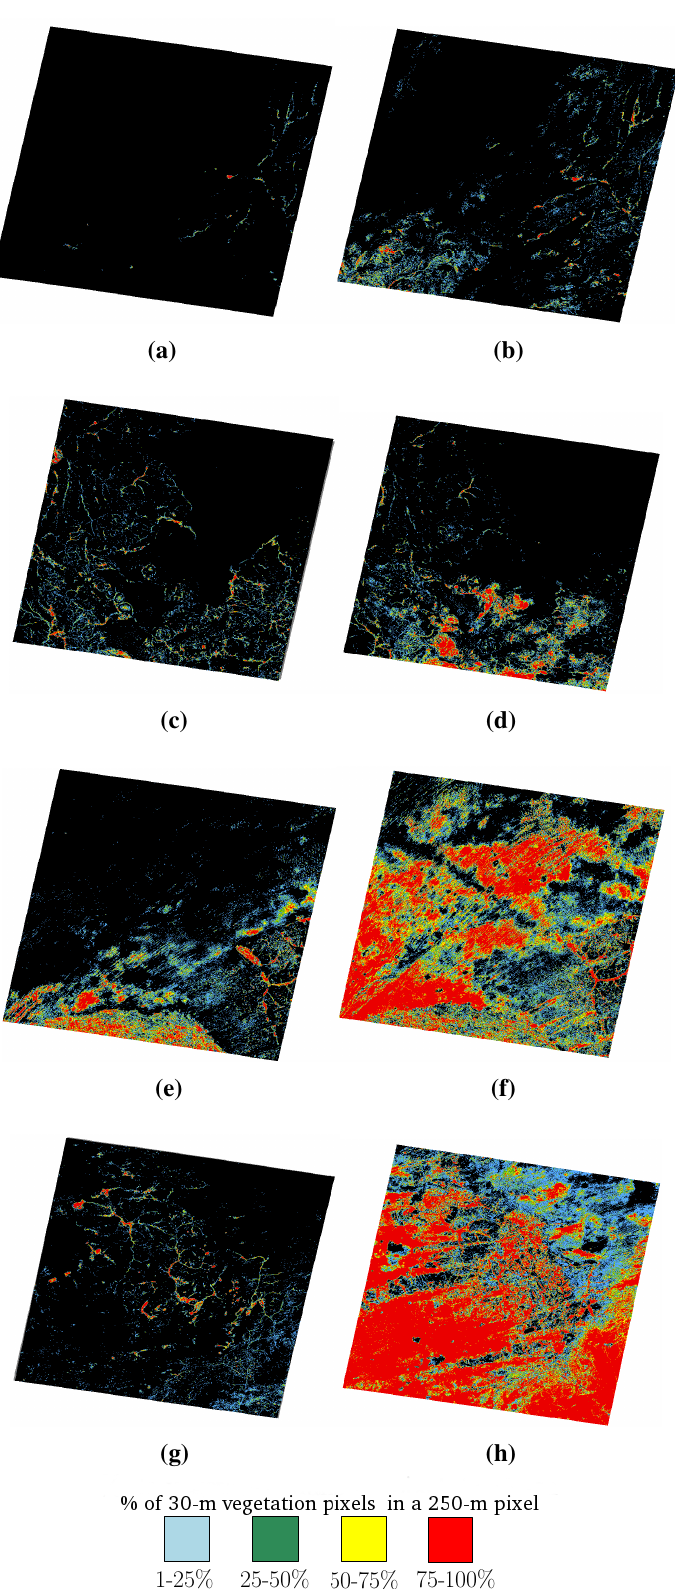
Figure 3. Percentage of vegetation in the reference maps aggregated at 250 m: ( a ) center-west 20 February 2010; ( b ) center-west 19 November 2010; ( c ) south Tidjikja 21 January 2010; ( d ) south Tidjikja 29 July 2009; ( e ) Chemama 20 February 2010; ( f ) Chemama 19 November 2010; ( g ) south Nema 17 February 2010; ( h ) south Nema 12 October